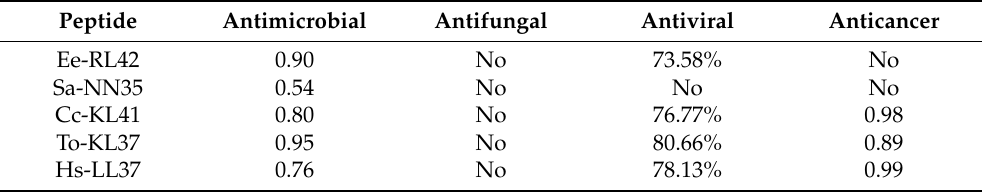
Table 4. Bioinformatic prediction of the biological activity for the putative peptides from the Eulipoty- phla order, including Talpa occidentalis , and using human cathelicidin Hs-LL37 as a reference. Values computed from different servers represent scores for each biological activity within the following numerical range: antimicrobial (0–1), antiviral (0–100%).